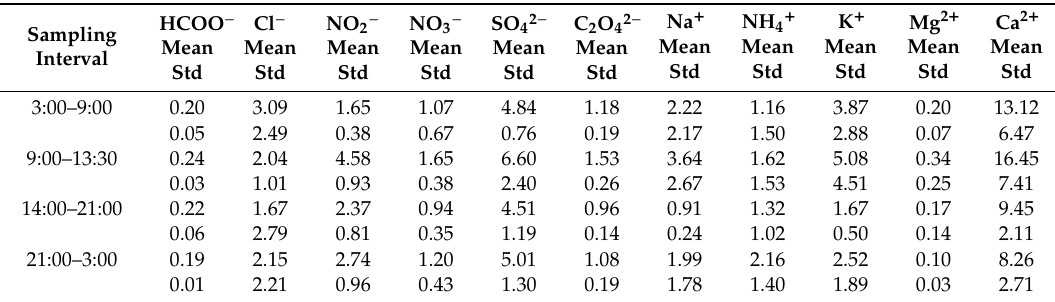
Table 2. Mean concentration and standard deviation for monitored ions in PM 2.5 samples during the four sampling